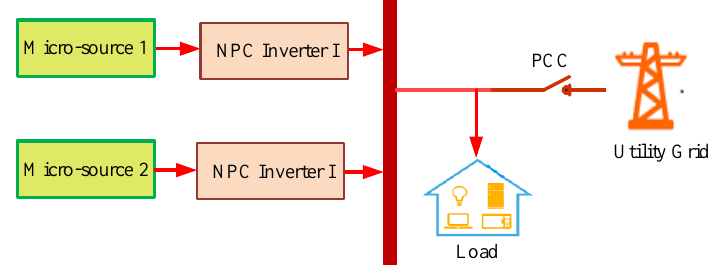
Figure 1. Structure of microgrid.